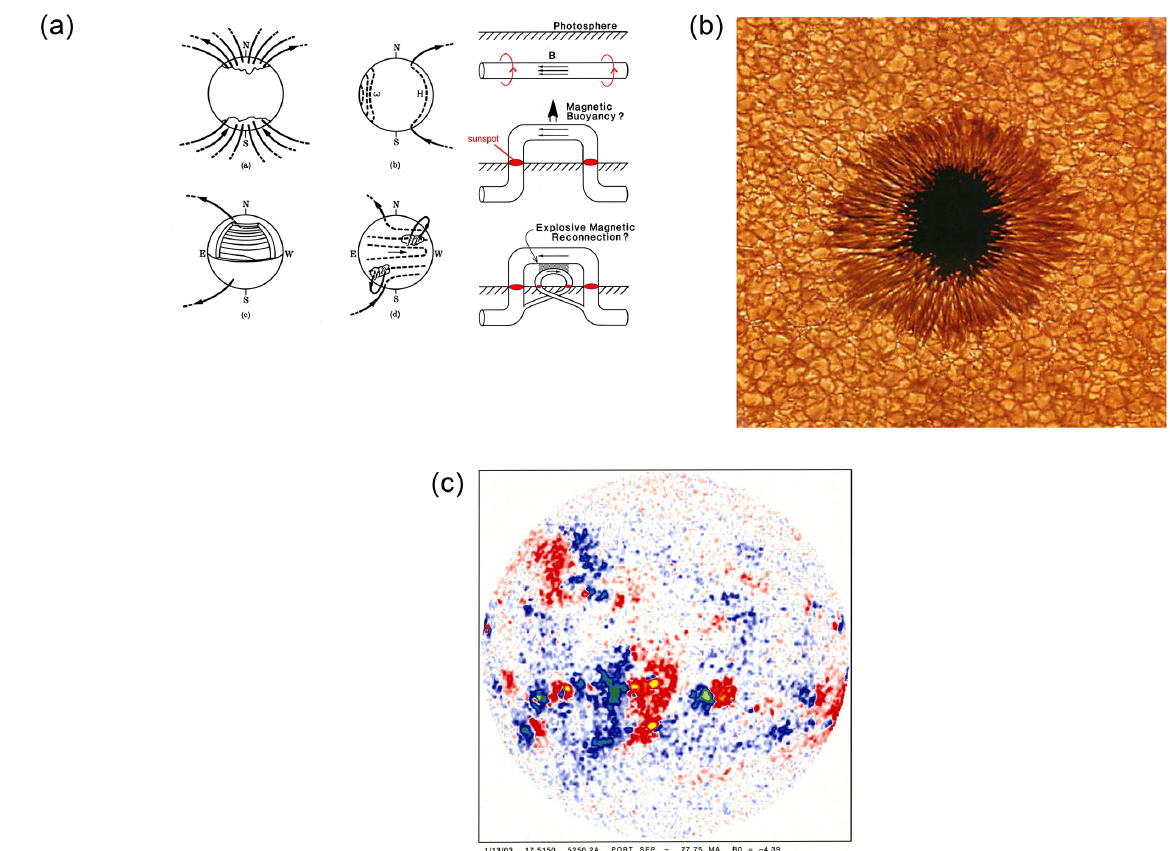
Figure 11. (a) Babcock’s model of the sunspot pair formation. (b) An example of single spot (courtesy of the Big Bear Observatory). (c) The figure shows that single spots (of positive polarity) are formed in the unipolar magnetic regions (of positive polarity), while sunspot pairs are formed at the boundary of two unipolar magnetic region of opposite polarity (courtesy of Mt. Wilson Observatory).